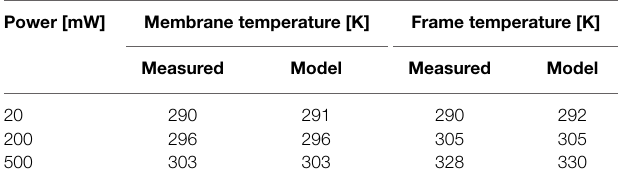
TABLE 1 | Modeled temperatures for a thermal conductivity of 8.0W/mK and measured temperatures of the membrane and the frame at atmospheric pressure when heating the frame with the 532nm